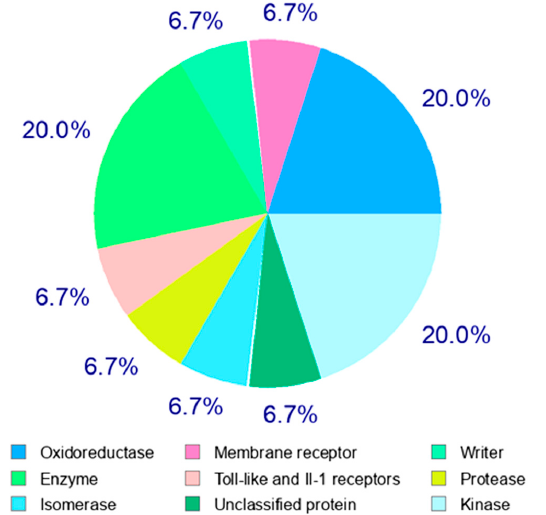
Figure 1. Basic structure and biosynthesis of curcumin. The figure represents the partial biosynthesis pathway of curcumin in turmeric: the JSMol model, enol and keto form of curcumin.